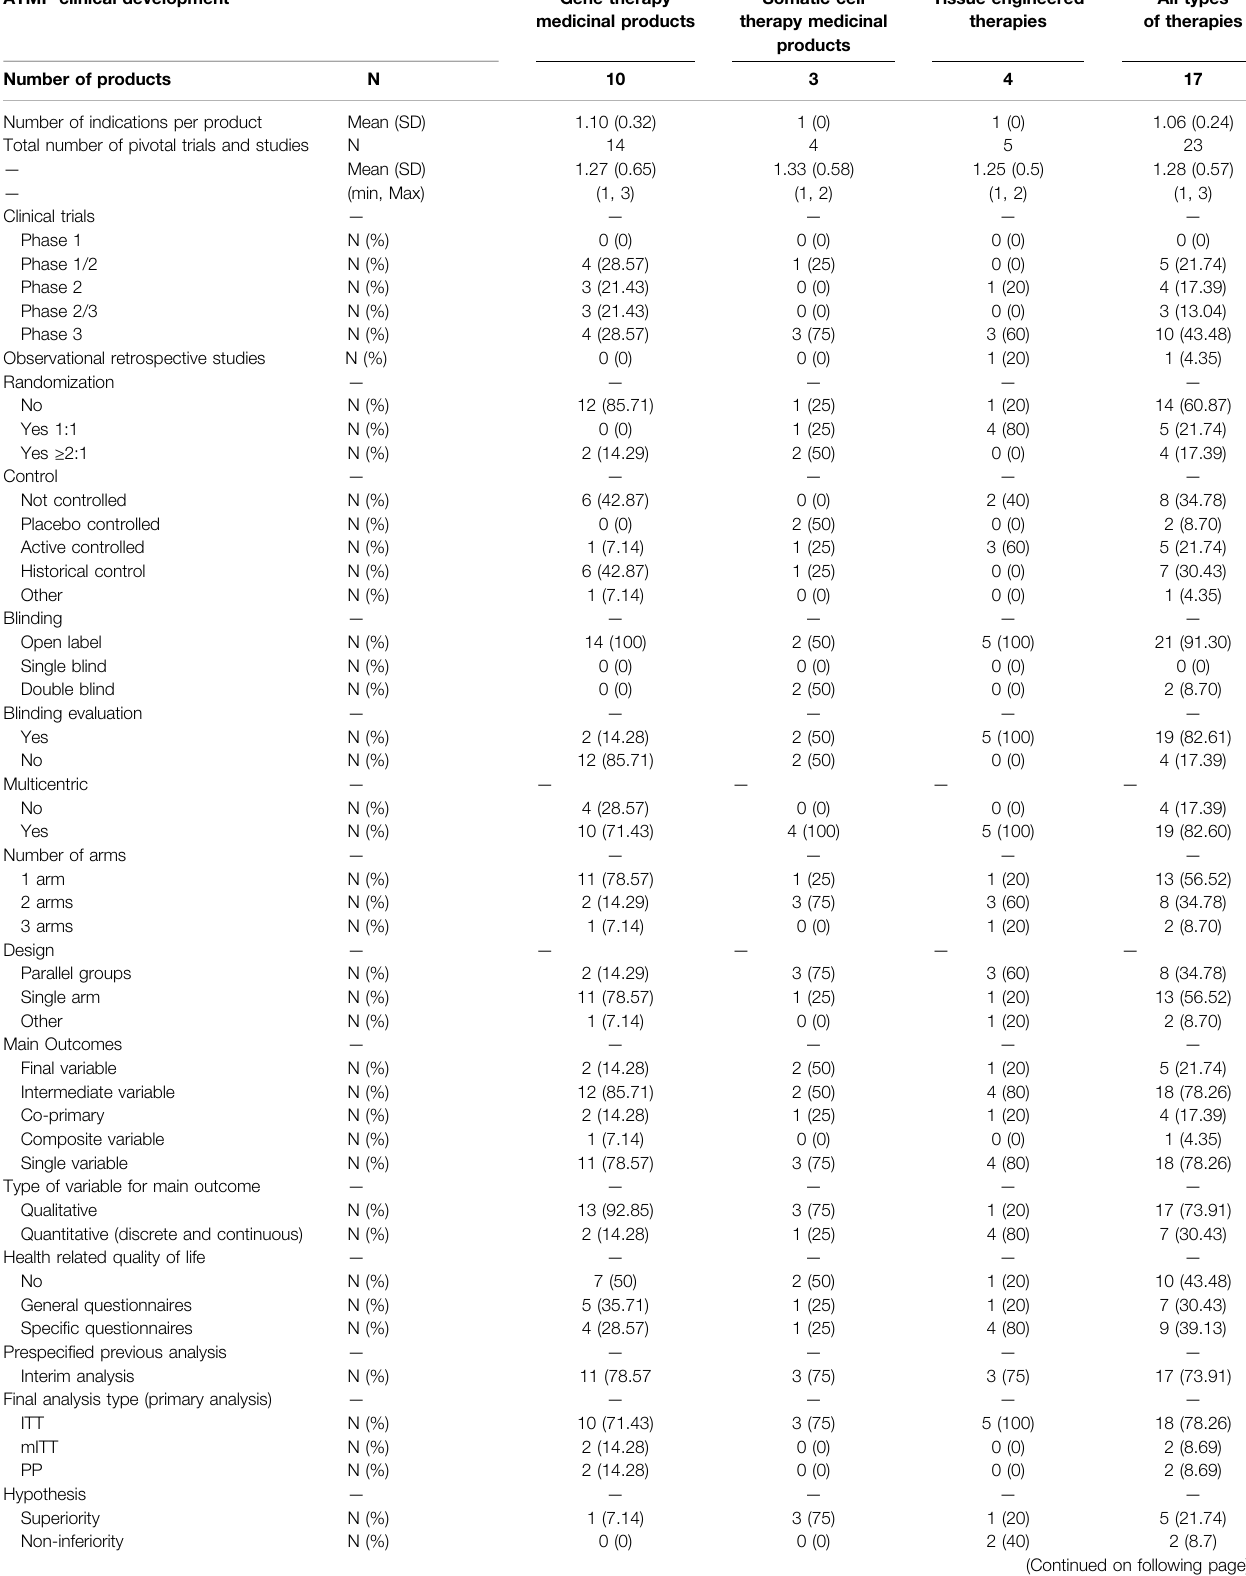
TABLE 2 | Design features of pivotal clinical trials for the approved advanced therapy medicinal products in the European Union.